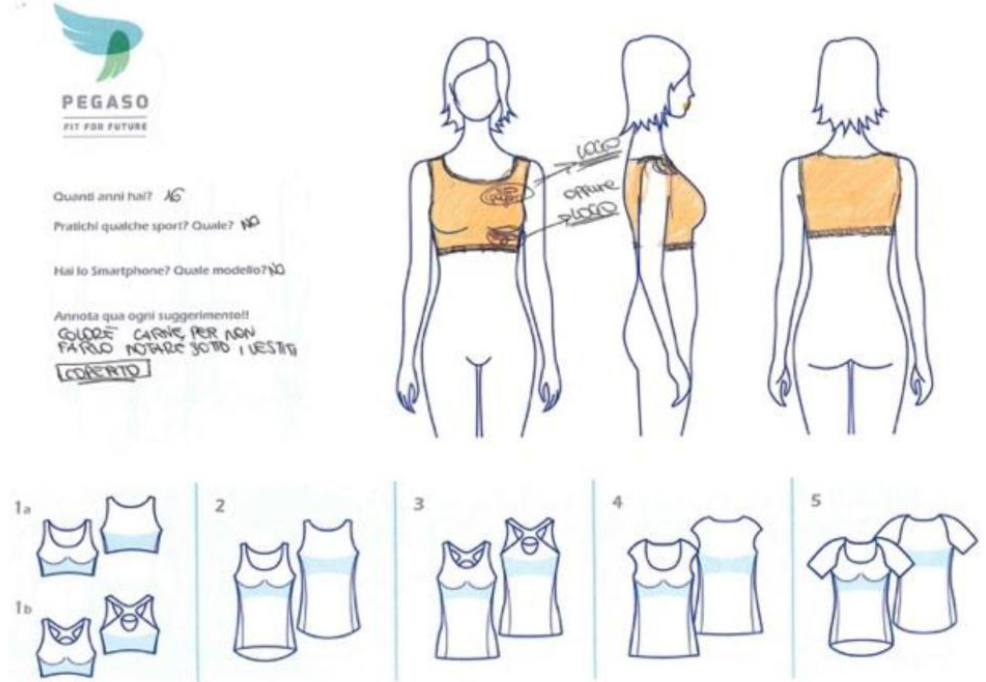
Figure 6. One example of the sketches produced by Italian teenagers for the co-design focus: the bra version according to the vision of a 15-year-old female student.